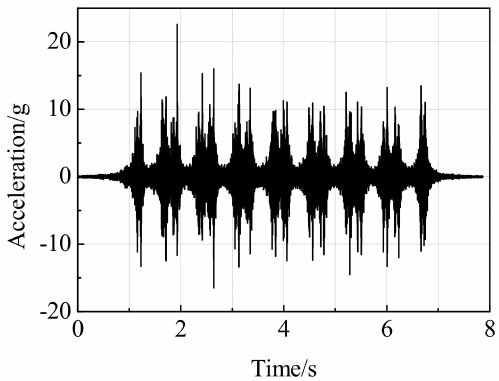
Figure 5. High-frequency D 1 signal recombination